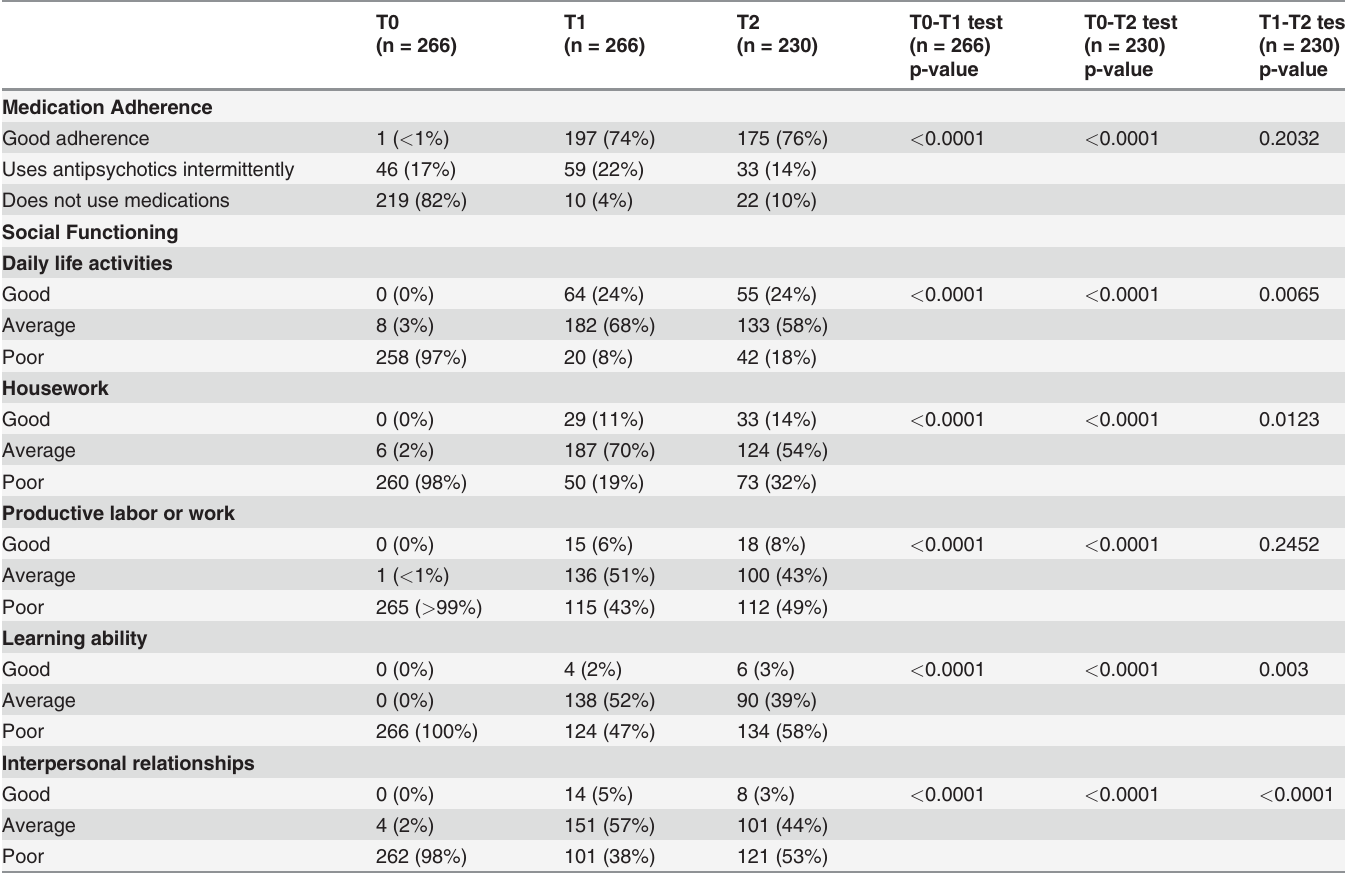
Table 3. Changes in patient medication adherence and social functioning (T0, T1 and T2